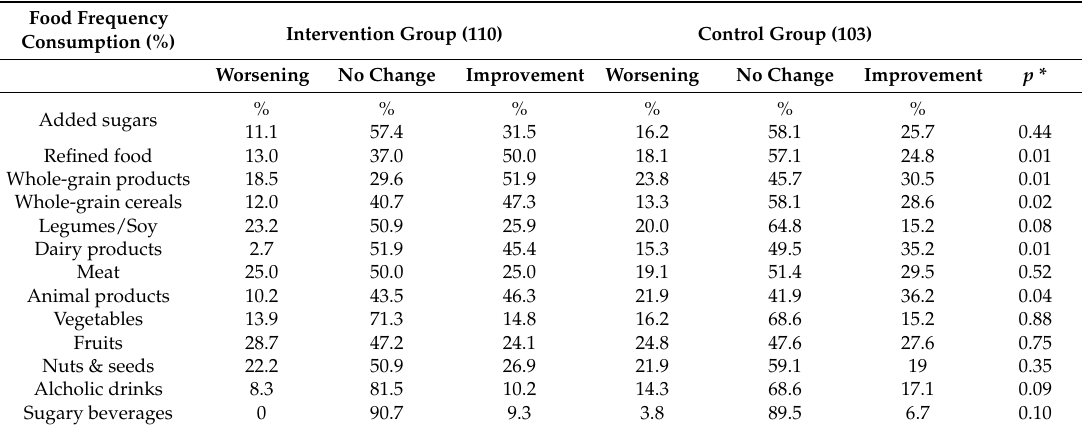
Table 5. Proportion of women who improved, worse or did not change food consumptions between baseline and end of the six-months dietary